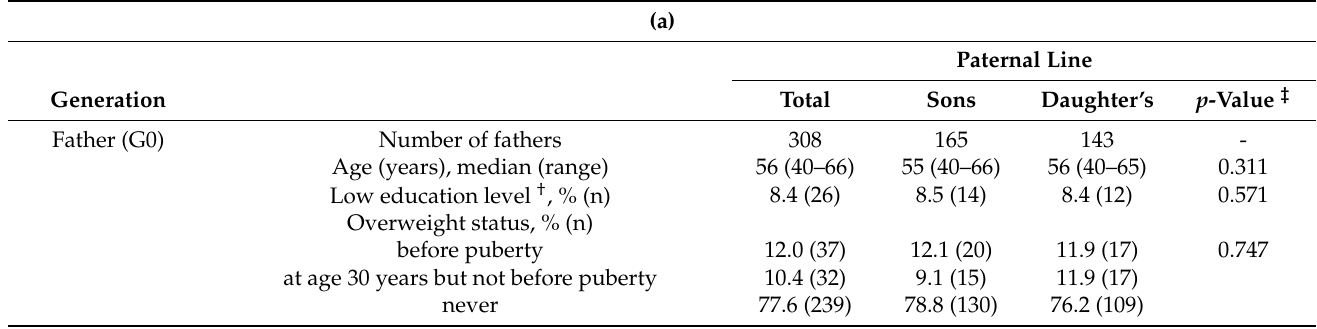
Table 1. ( a ) Main characteristics of fathers and offspring in the paternal line. ( b ) Main characteristics of mothers and offspring in the maternal